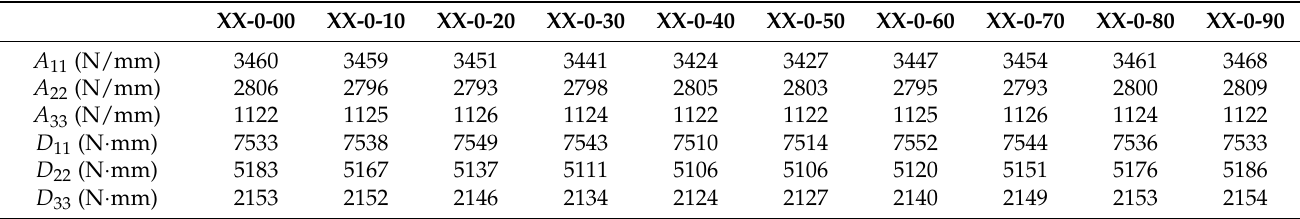
Table 4. The selected stiffnesses in models without imperfections and with different